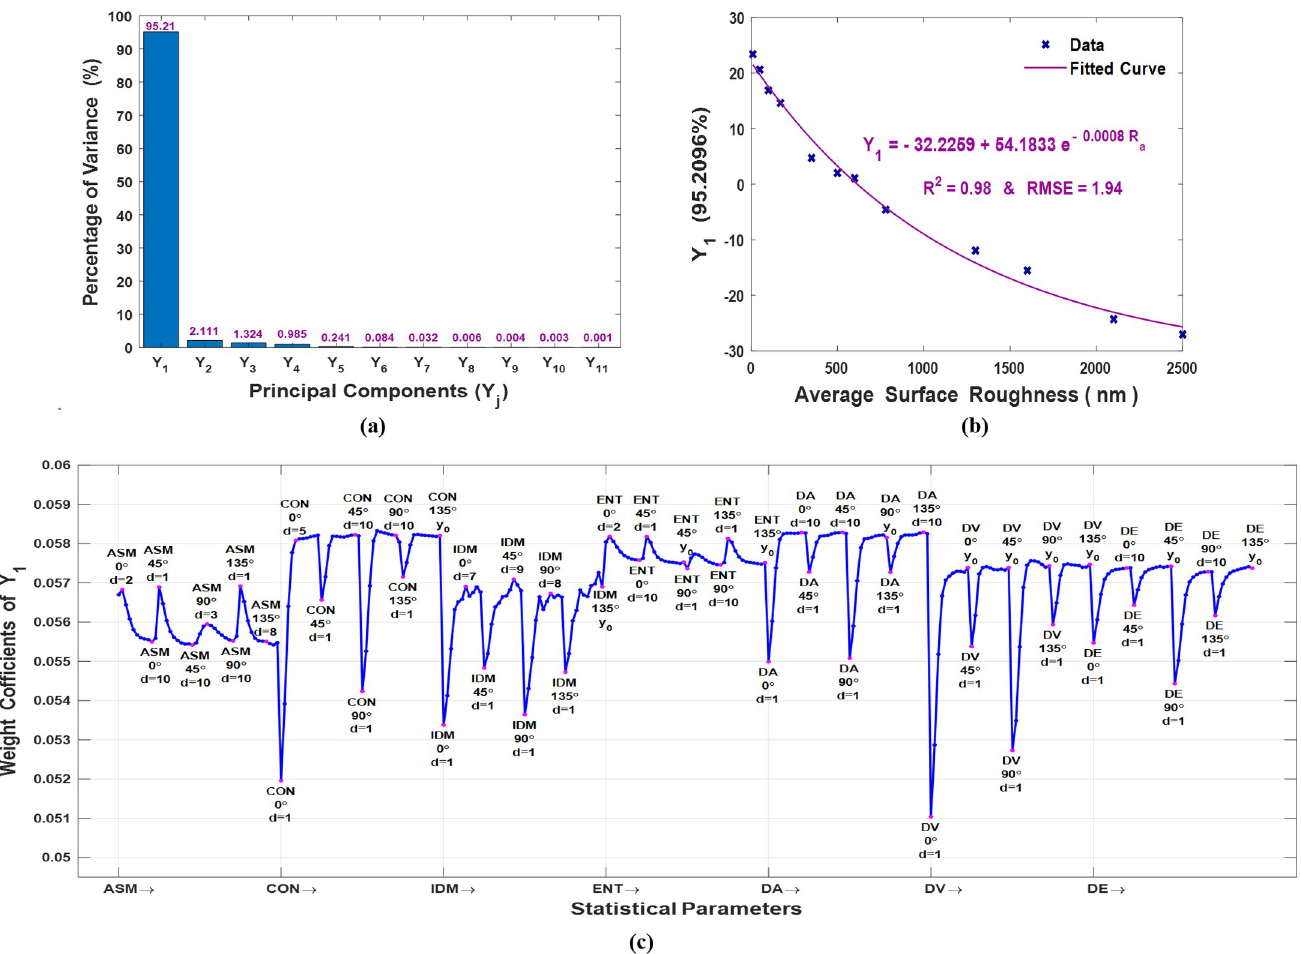
Fig 10. Principal component analysis: (a) percentage of the total variance of the principal components, (b) the first principal component versus average surface roughness, and (c) the weight coefficients plot of the first principal component.